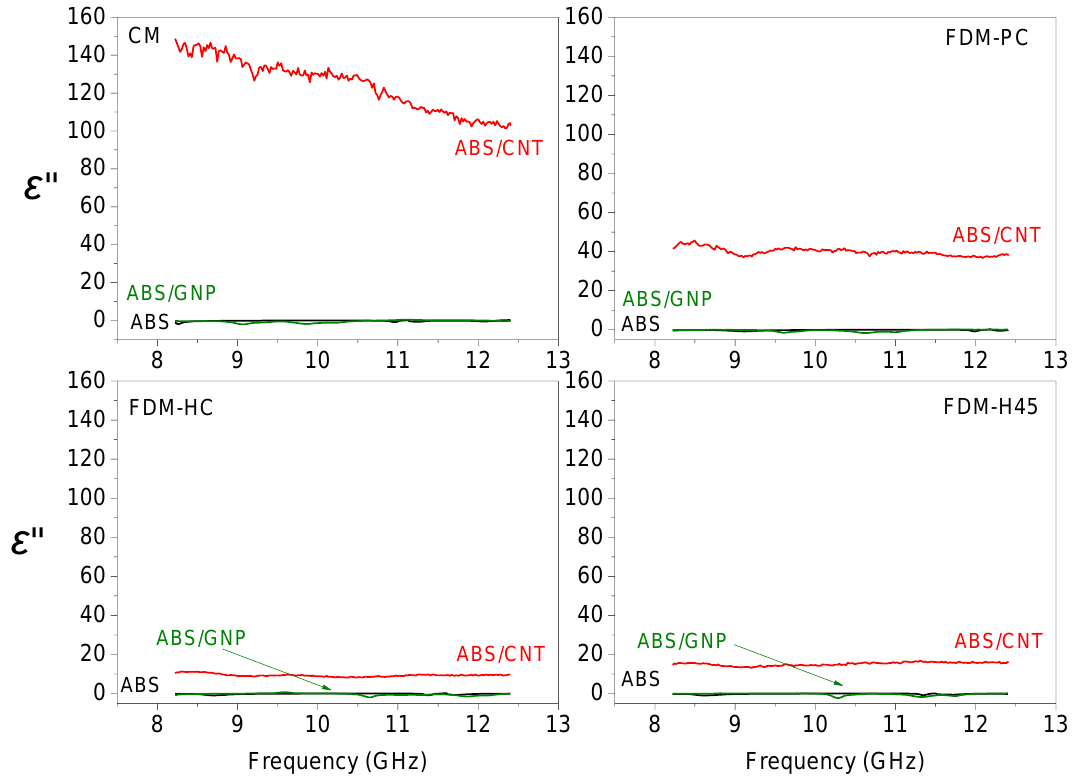
Figure 13. Dielectric loss of ABS and its composites in the X-band frequency range.